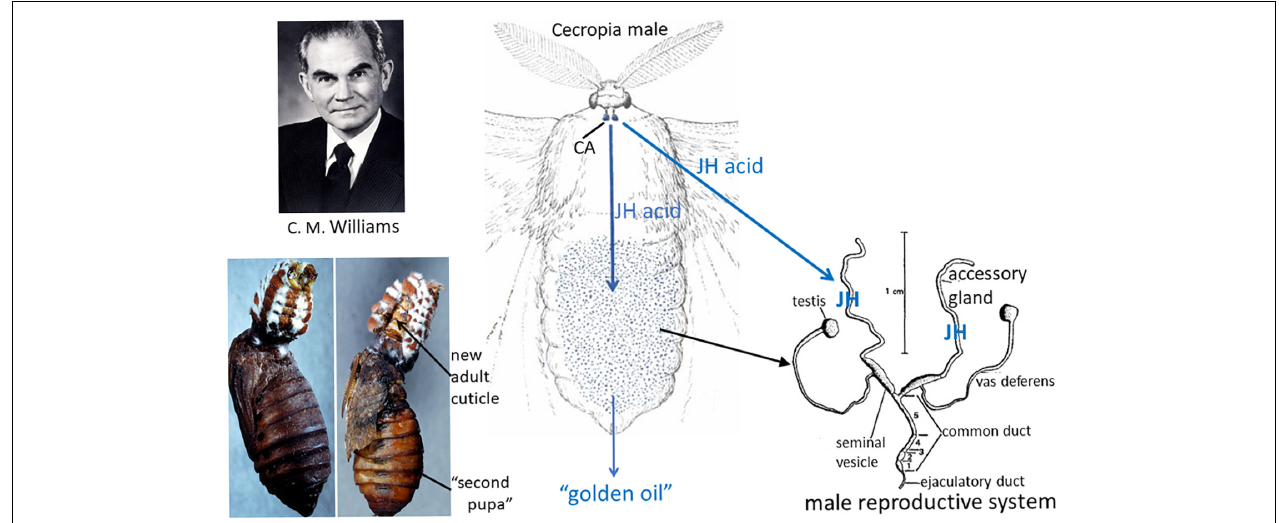
FIGURE 4 | Left : (Top) Carroll M. Williams. Photo from his memoir in the National Academy of Sciences Memoir collection. (Bottom) Cecropia male abdomen parabiosed to a chilled diapausing Cecropia pupa (left); after 21 days, the “second pupa” had formed and the abdomen had molted to a scaleless adult abdomen (right, arrow) (from the original slides taken by Muriel V. Williams that were used for the black-and-white Figures 3, 4 in Williams, 1963). Center : Diagram of the Cecropia male moth whose corpora allata (CA) synthesize and secrete juvenile hormone (JH) acid and from whose abdomen the “golden oil” that contained JH was extracted (drawing of the moth modified from a figure in Williams, 1958). Right : Reproductive system of a male saturniid moth (modified Figure 1 in Shepherd, 1974). The accessory glands of Cecropia males synthesize JH from the JH acid that is secreted from the CA, then store the hormone (Shirk et al., 1976; Peter et al., 1981).